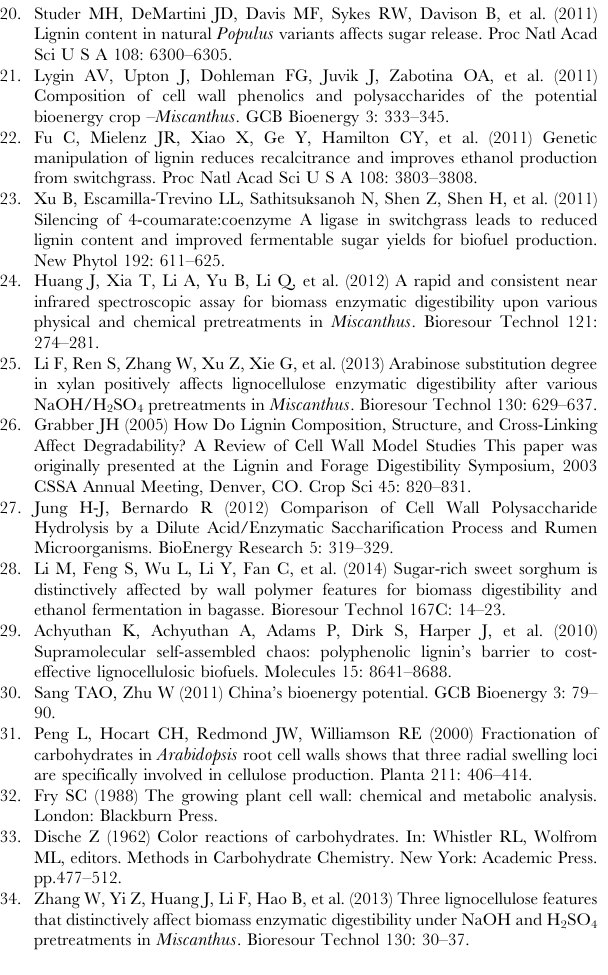
Figure S5 Biomass enzymatic digestibility and scanning electron microscopic observation in representative Mis- canthus accessions. (A) Hexoses yields (% cellulose) released from enzymatic hydrolysis after pretreatments of NaOH and H 2 SO 4 at three concentrations as means 6 SD (n = 3); (B) SEM imagines of the biomass residues obtained from pretreatments of 1% NaOH and 1% H 2 SO 4 and sequential enzyme hydrolysis, Allow indicated a coarse face.